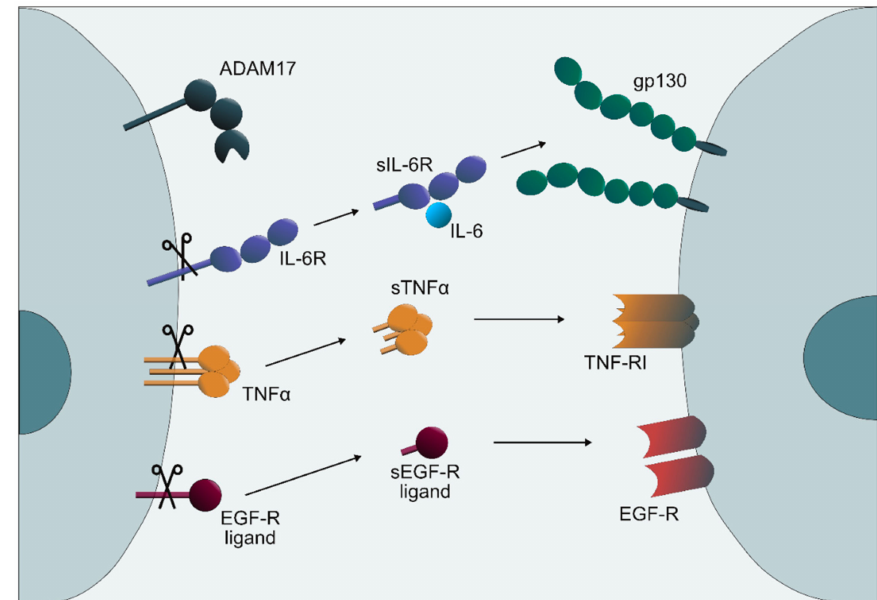
Figure2. ADAM17isamembrane-boundmetalloprotease, whichcleavesmorethan80substrates[44,45]. Major substrates of ADAM17 are IL-6R, TNF α , and ligands of the EGF-R. Cleavage of the IL-6R is a prerequisite of the pro-inflammatory IL-6 trans-signaling pathway via the sIL-6R. Cleavage of TNF α and the formation of soluble TNF α (sTNF α ) leads to the stimulation of the pro-inflammatory TNF α receptor 1 (TNF-R I ). Cleavage of ligands of the EGF-R is needed for the systemic activity of the ligands and therefore for the full stimulation of the EGF-R